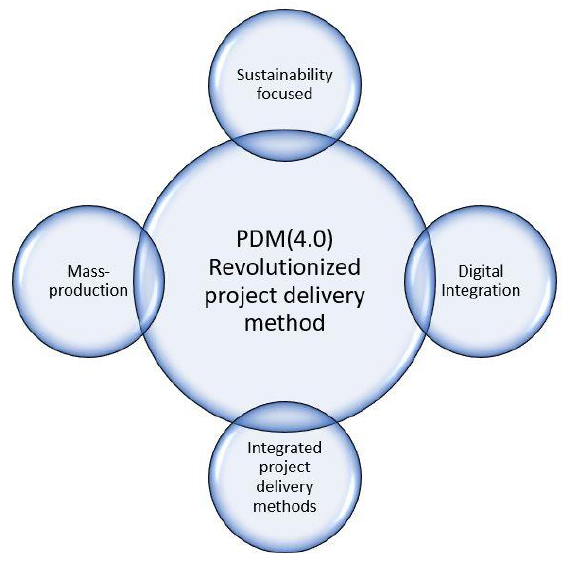
Figure 5. Features of PDM 4.0.